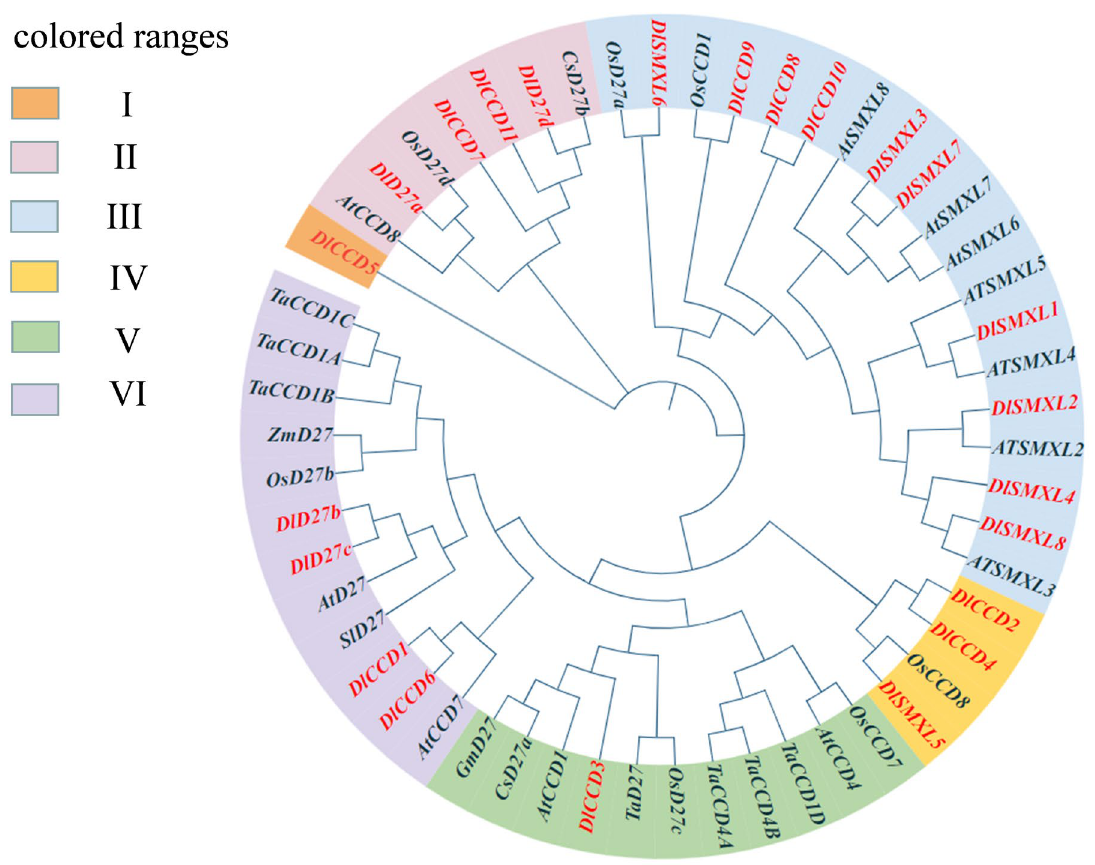
Figure 2. Phylogenetic tree of CCD, SMXL, and D27 family genes. The different-colored areas indicate different groups.